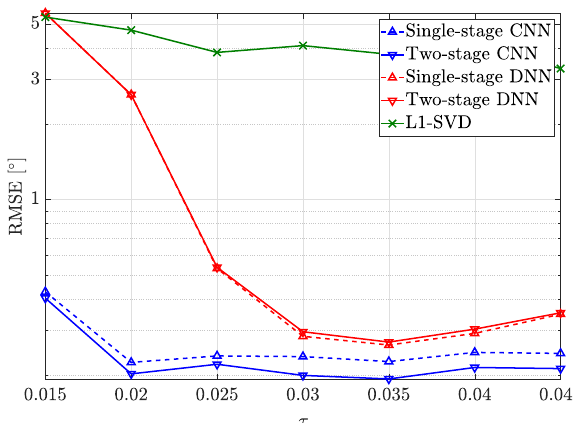
Figure 6. The RMSE versus τ . Q = 1000 and the SNR is set to 10 dB. | θ 1 − θ 2 | is about 1.7 ◦ around 90 ◦ when τ = 0.015 and is about 5.2 ◦ around 90 ◦ when τ =